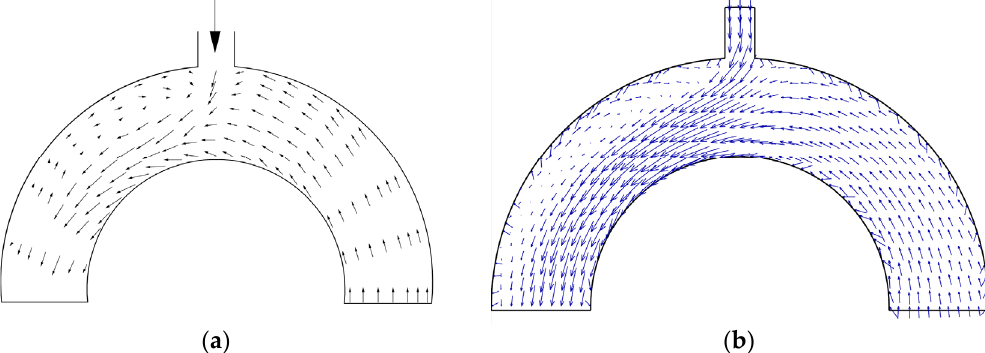
Figure 6. Comparisons of the mean streamwise velocity profiles of the test lines between the simu ‐ lation results and experimental data.